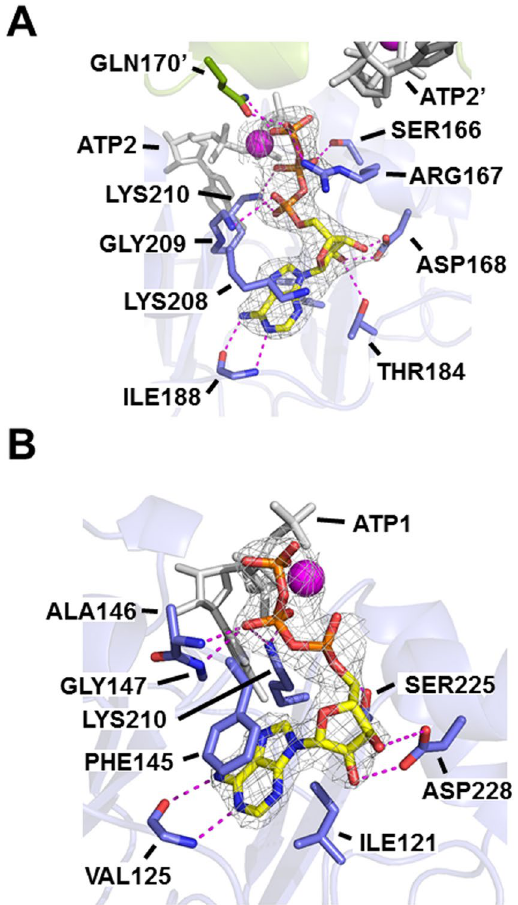
Figure 3. The Bateman domain of AgIMPDH binds two ATP molecules. Close-up view of the ATP1 ( A ) and ATP2 ( B ) bound to the canonical nucleotide binding sites of the Bateman domain of AgIMPDH. AgIMPDH protein is represented in blue semi-transparent cartoons with key interacting residues and ATP molecules shown in sticks. The Mg + 2 ion is shown as a magenta sphere. In ( A ) the adjacent monomer and the side chain of residue Gln170’ are shown in green cartoon and sticks, respectively. Key interactions are represented as magenta dashes. The grey mesh around the nucleotides and the Mg + 2 ion represents the ommit 2mF o − DF c electron density map contoured at the 1 σ